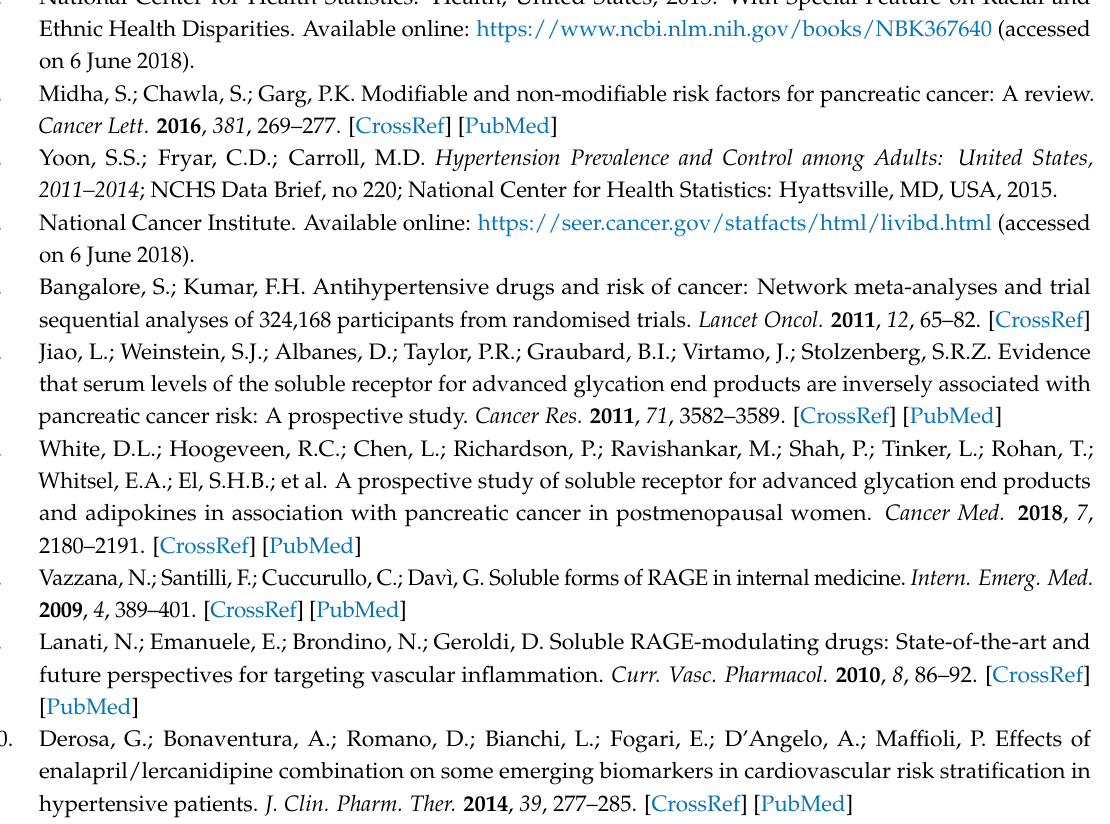
Table S1: Baseline antihypertensive medication use status in association with risk of incident pancreatic cancer among subjects with self-report hypertension, Table S2: The duration of use of DHP- and non-DHP CCBs in association with risk of incident pancreatic cancer, Table S3: Baseline CCB use and risk of incident pancreatic cancer by potential effect modifiers in the WHI Study, Table S4: Duration of CCB use at baseline and risk of incident pancreatic cancer after excluding first 2 years of follow-up, Figure S1: Average serum sRAGE level by single anti-HT medication use among controls in the WHI Study ( n =